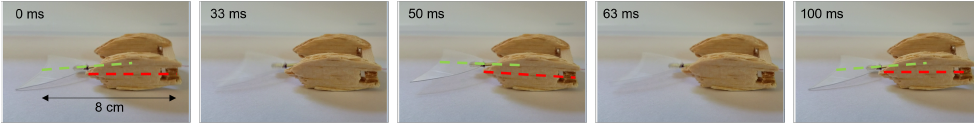
Figure 16. Oscillation in air of a fish-inspired geometry with tail fin driven by impact-based amplifi- cation mechanism. Red and green lines indicate angle of body and fin midlines, with approximately 5 degree body rotation and 5 degree fin rotation relative to the